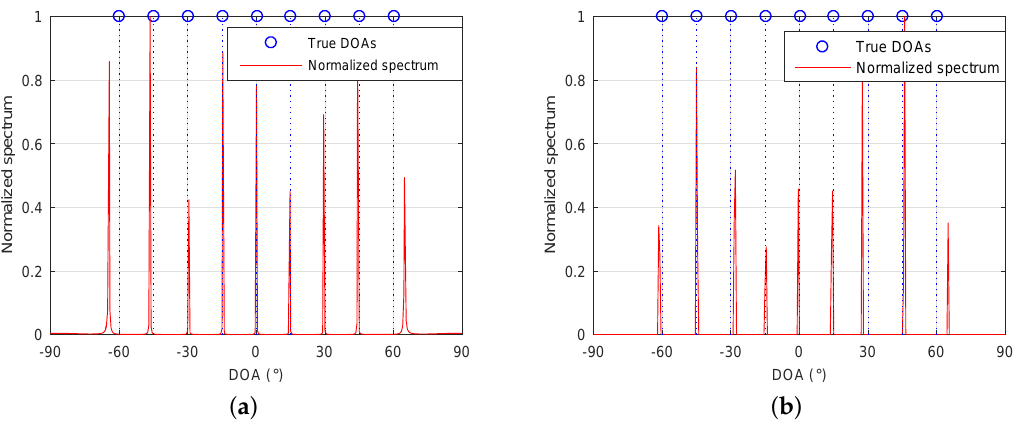
Figure 1. Normalized spectra of ( a ) the proposed method and ( b ) 4-L1. S = { 1,2,6 } × d , K = 9, L = 10 4 , signal–noise ratio ( SNR ) = 20, and r = 0.5 ◦ . DOA: direction of